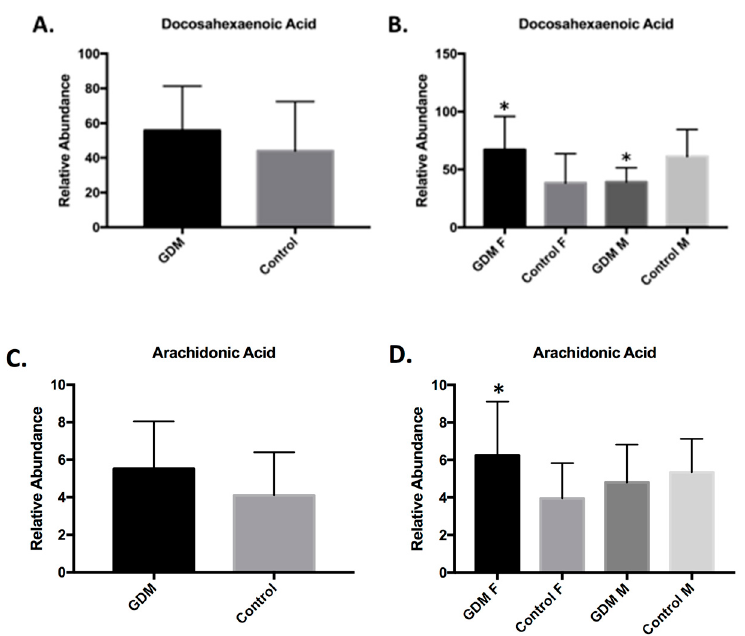
Figure 2. Docosahexaenoic acid (DHA) and arachidonic acid (AA) concentrations are increased in AF from female offspring exposed to GDM as measured by high resolution LC/MS analysis. ( A ) AF DHA relative abundance, all samples. ( B ) AF DHA relative abundance sex-specific analysis. ( C ) AF AA relative abundance, all samples. ( D ) AF AA relative abundance sex-specific analysis. * p < 0.05.